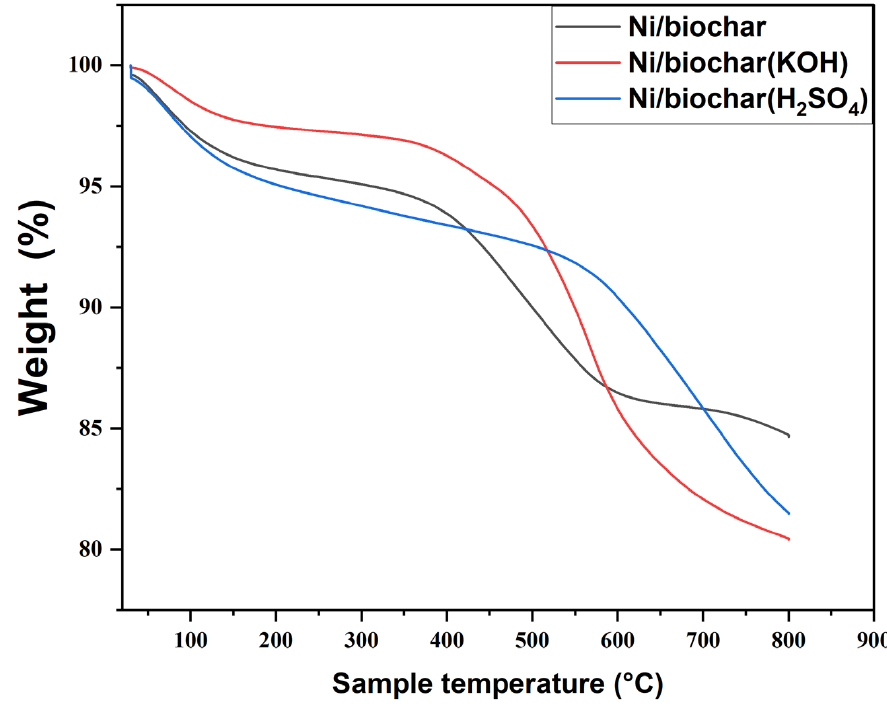
Figure 8. TGA thermogram of Ni/biochar, Ni/biochar (KOH) and Ni/biocharH 2 SO 4 catalysts.